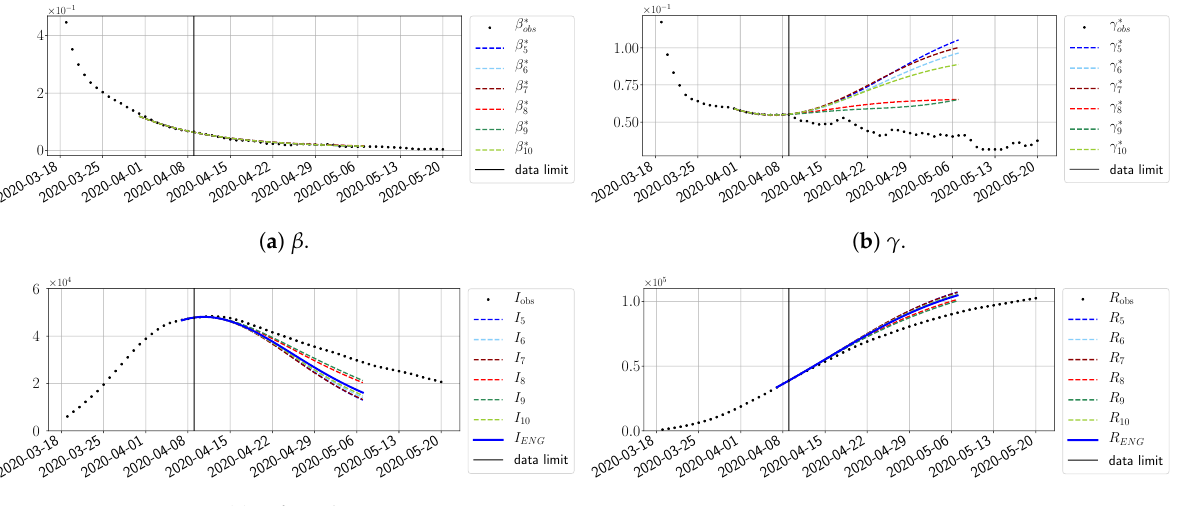
Figure 29. ENG forecast from T =